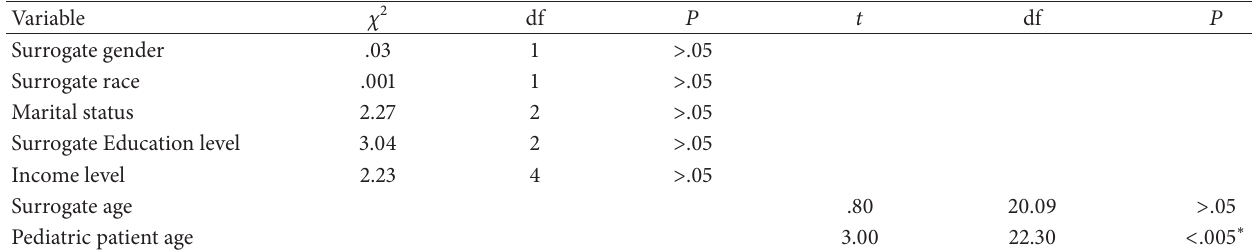
Table 2: Demographic factors associated with decision to participate in the